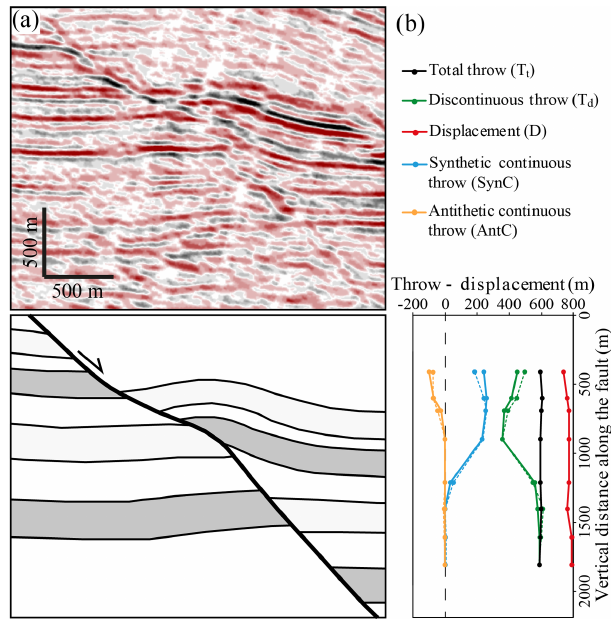
Figure 5. (a) Uninterpreted and interpreted seismic profile of a non- planar fault and associated hangingwall deformation in the north- western Porcupine Basin, offshore western Ireland. (b) Throw- displacement profiles along the fault in (a) showing the comple- mentary variations in the discontinuous and continuous throws and the distributions of the total throw and the displacement that are unaffected by the fault bends. The modelled discontinuous and con- tinuous throws are also plotted with dashed